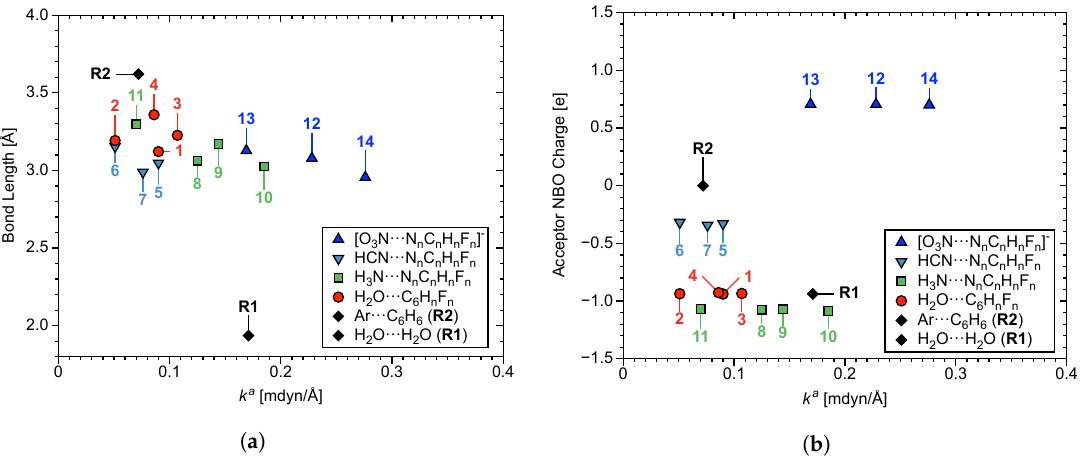
Figure 4. Calculated at the ω B97X–D/aug–cc–pVTZ level of theory, ( a ) r , and ( b ) NBO charges of the central acceptor atoms O and N; plotted with respect to k a of π –hole interactions in 1–14 . There is weak correlation at best between r and k a , which becomes weaker by presence of R1 and R2 . The π –hole interaction length in 14 is 1.000 Å longer than the HB in R1 , yet the former has a k a value 0.100 mdyn/Å larger than the latter. The Ar ··· C H interaction in R2 is at least 0.200 Å longer 6 6 than all 14 π –hole interactions, but is stronger than 2 , 6 , and 11 . Figure 5a,b show charge transfer (CT) and BE counterpoise corrected for basis set superposition error; both plotted with respect to k a . CT was calculated as the transfer of charge between the acceptor lp–donor atom and the aryl ring. Both of these parameters correlate weakly with bond strength in terms of k a , but BE and k a show the best correlation of any properties considered in this work. Increase in magnitude of BE weakly correlates with increase in bond strength. The HB in R1 has a k a value three times larger than the weakest π –hole interactions ( 2 and 6 ). On the other hand, 14 contains the strongest π –hole interaction in this work with a k a value 60% larger than k a of the HB in R1 .